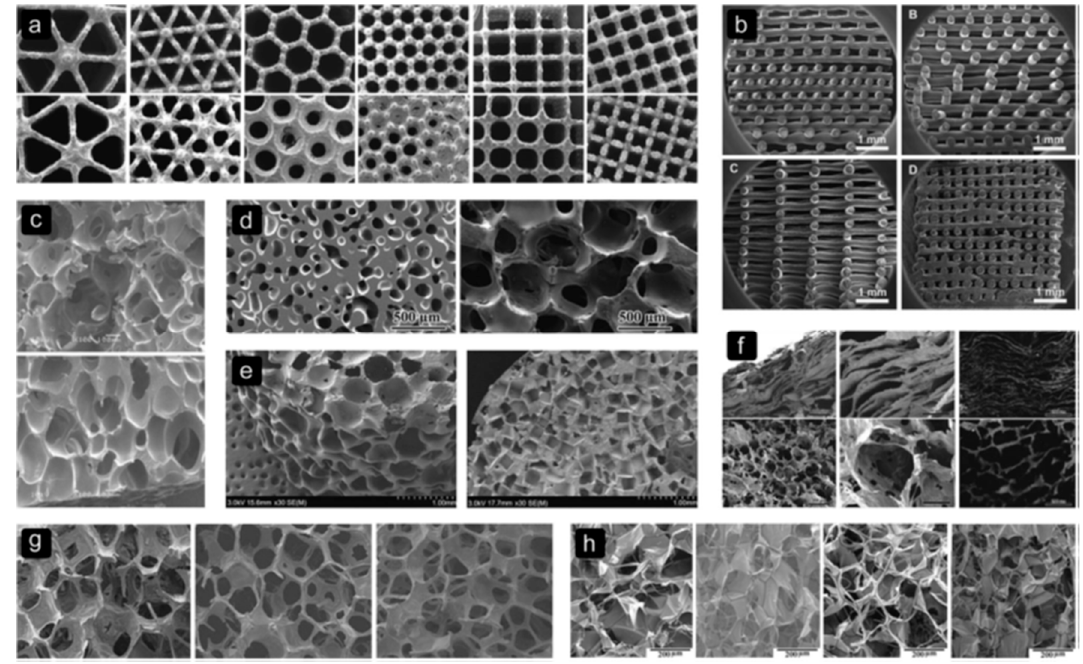
Figure 2. Examples of different pore sizes, shapes, and biomaterials for scaffolds for tissue engineering. ( a ) Titanium (Ti6Al4V), ( b ) Starch poly( ε -caprolactone) (SPCL), ( c ) poly(lactide-co-glycolide) (PLGA), ( d ) Bioactive glass (BG), ( e ) poly(propylene fumarate) (PPF), ( f ) collagen-apatite, ( g ) Mesoporous bioactive glass (MBG), and ( h ) Silk fibroin (SF). Reproduced from [39], CC BY 3.0